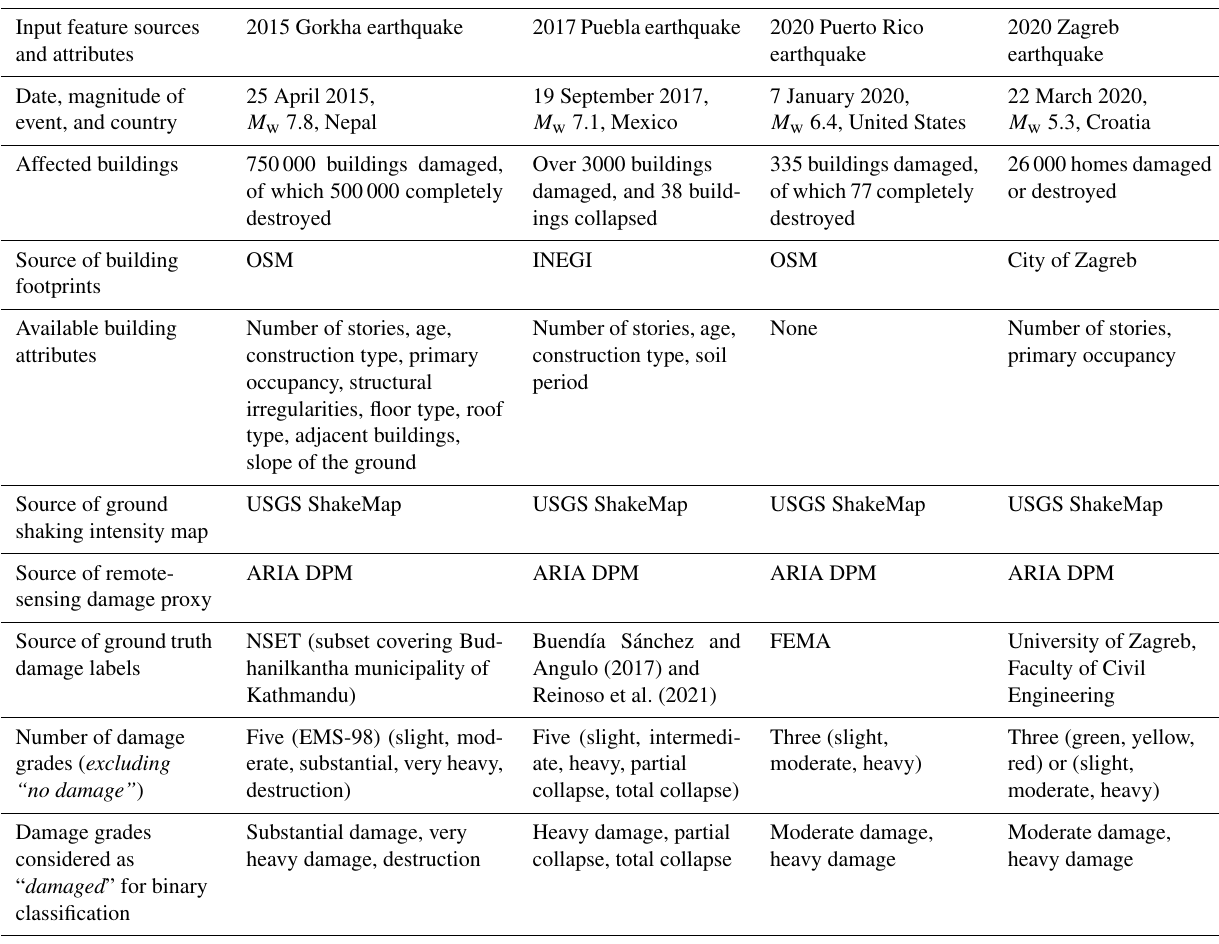
Table 1. Data sources and available input features for the case study earthquakes.